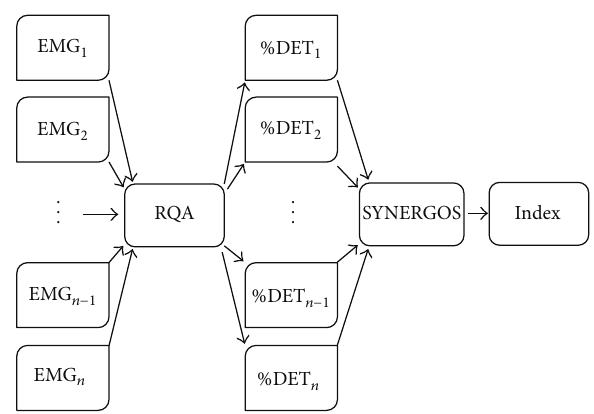
Figure 1: The schematic view of the SYNERGOS algorithm. EMG signals are analyzed using the RQA, and the output for each muscle, %DET, is imported into the SYNERGOS algorithm, which eventually provides a single scalar index representing the state of